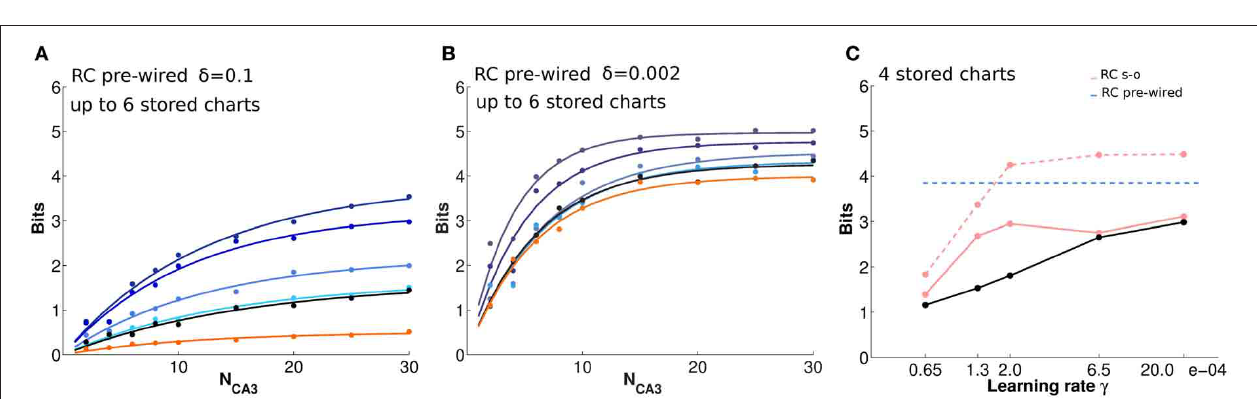
FIGURE 5 | The storage capacity for multiple charts is limited, but substantial residual information remains. (A and B) Information plotted versus the number of CA3 units in the sample, for a substantial noise level, δ = 0 . 1 (A) , and for lower noise, δ = 0 . 002 (B) . The two panels show the average amount of information retained through pre-wired recurrent collateral weights, in absence of the input, about position in one environment, after the storage of 1, 2, 4, and 6 charts, indicated by curves from purple to light blue, i.e., from top to bottom. The black curves indicate the amount of information retrieved through recurrent collaterals about a chart that had never been stored, when 6 other charts were learned, the “residual information.” If no learning sessions had occurred, however, the curve would be flat at the